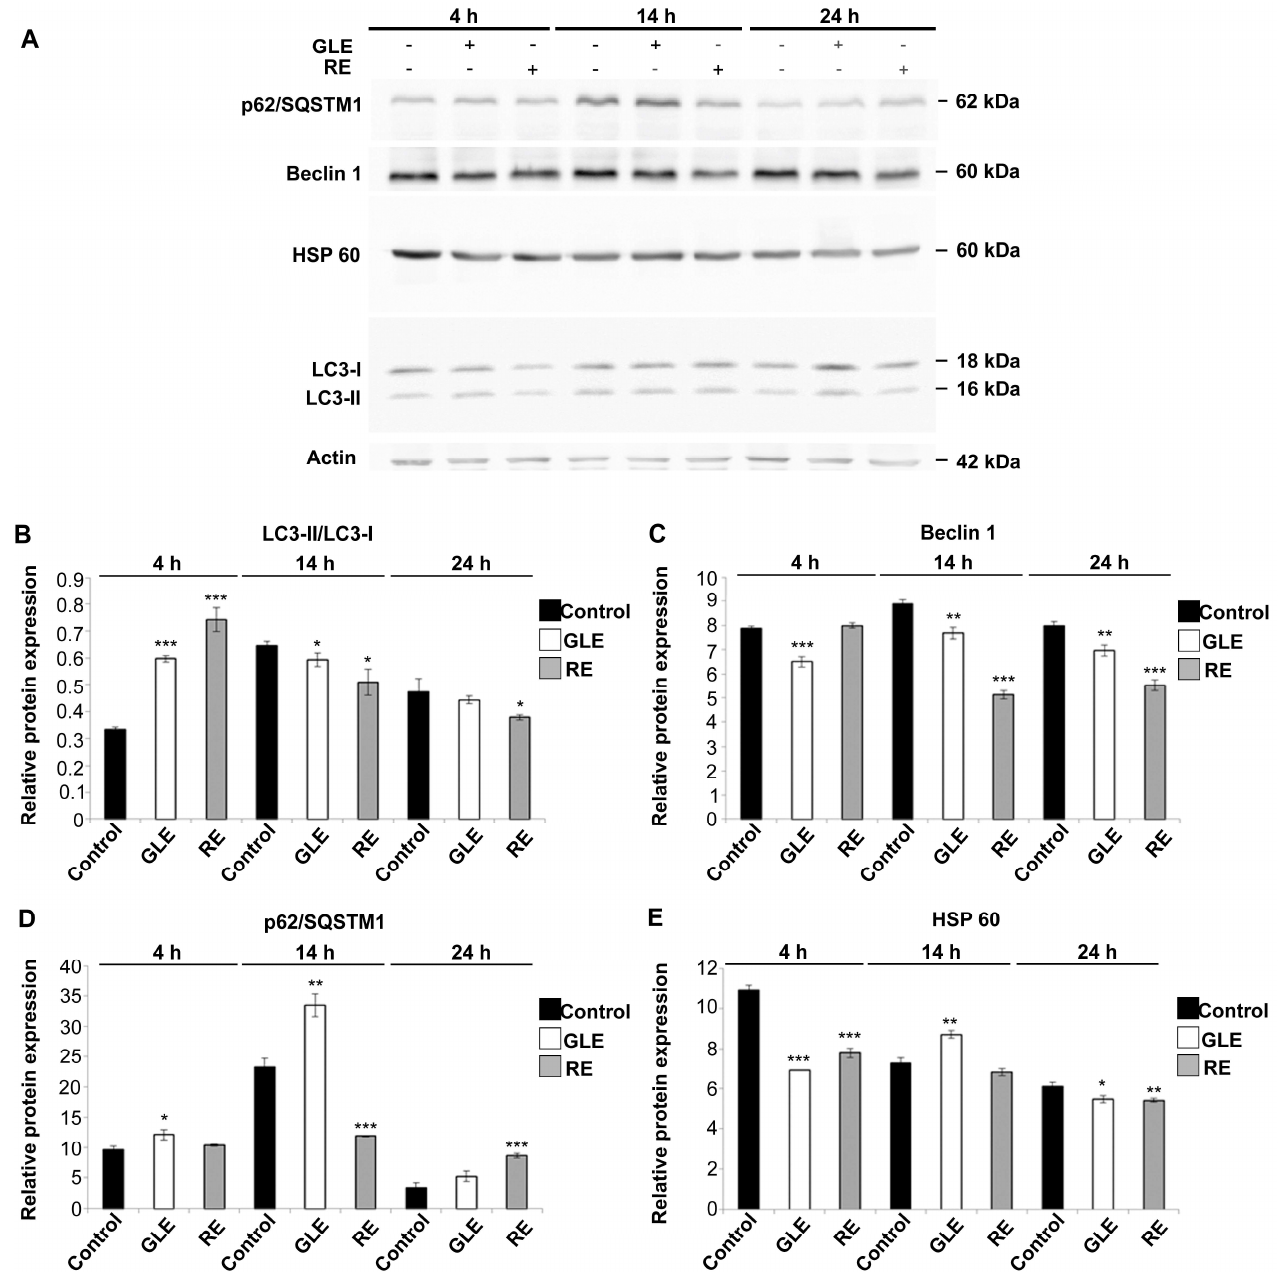
Figure 8. (Upper panel) flow cytometric assays for AVOs in HepG2 cells cultured in control conditions or exposed to the IC 50 of GLE or RE for 4, 14, and 24 h. The plots show the results of representative experiments and the percentages, indicated as the mean ± s.e.m. of three independent experiments, refer to AVO + cells (right quadrants) and AVO - cells (left quadrants). (Lower image) bar graph summarizing the data for control and treated AVO + cells obtained from triplicate experiments. * normality test vs. control passed.